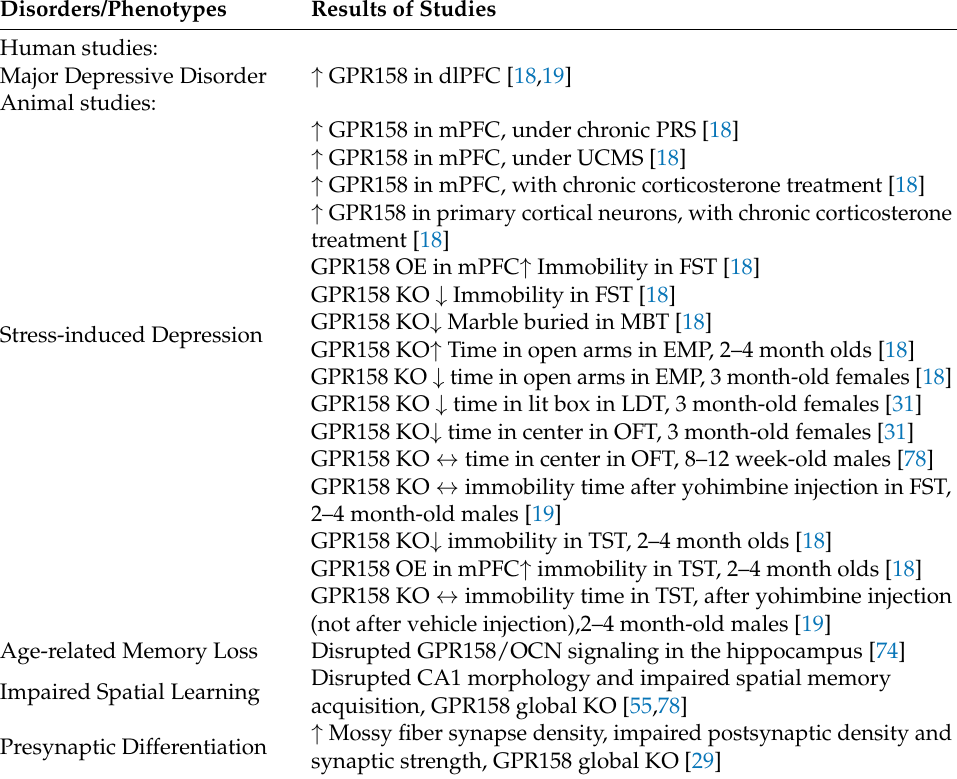
Table 1. Roles of GPR158 in affective